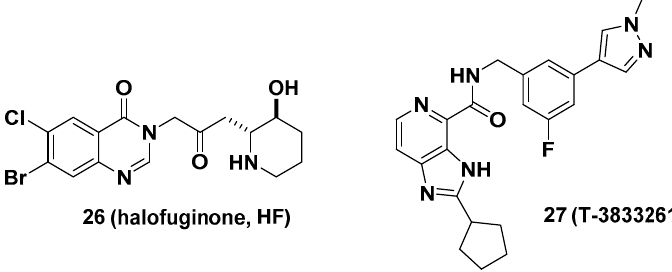
Figure 10. Antifibrotic prolyl-tRNA synthetase (ProRS) inhibitors halofuginone and T-3833261.